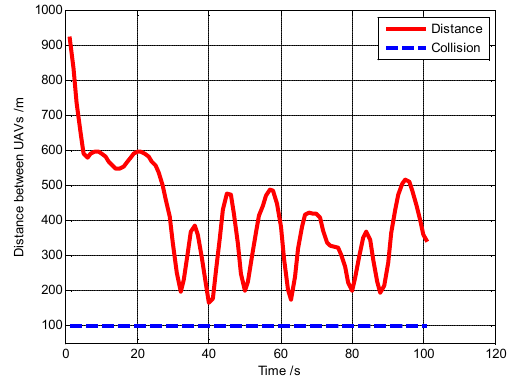
Figure 11. The distance between the UAVs during the simulation process (Group A in Scenario 1).